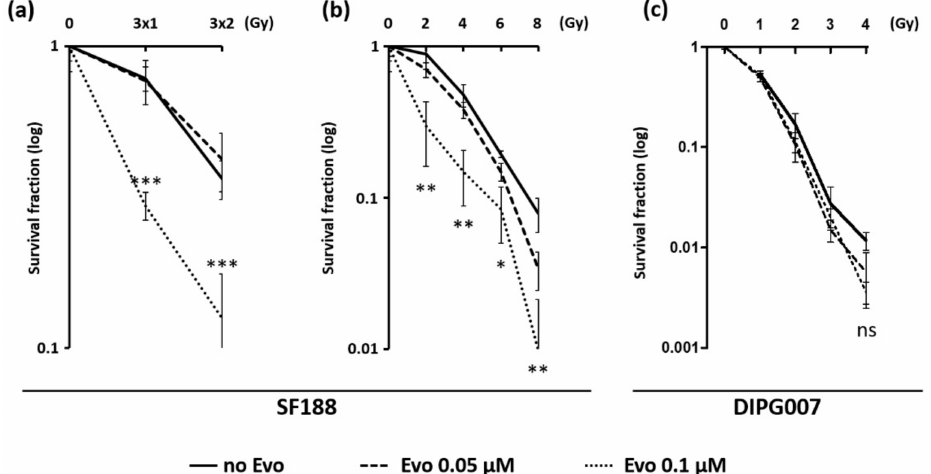
Figure 4. Radiosensitizing effect of Evo on SF188 and DIPG007 cell lines. The combination effect of Evo with ionizing radiation was determined by a clonogenic assay. Cells were treated with 0, 0.05, or 0.1 µ M Evo under 1% O 2 hypoxia and irradiated six hours later. ( a ) SF188 cells were irradiated with fractions of 0, 1, or 2 Grays each day for three consecutive days or ( b ) with 0, 2, 4, 6, or 8 Grays as single doses. ( c ) DIPG007 cells were irradiated with 0, 1, 2, 3, or 4 Grays as single fractions ( c ). After 10 days under 1% O 2 hypoxia, colonies were counted, and the survival fraction was calculated for each condition. Results are means values +/ − SD and are representative of three independent experiments. *** p < 0.0001; ** p < 0.001; * p <